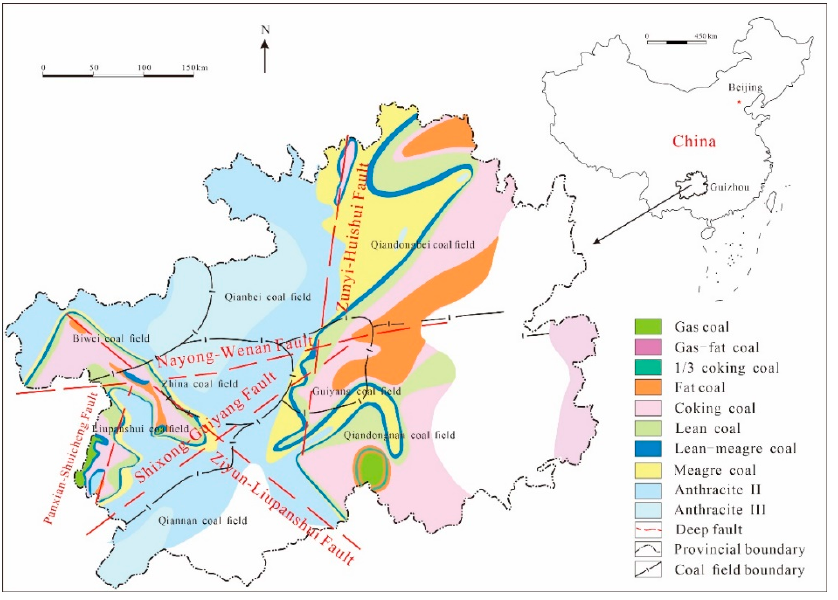
Figure 4. Relationship between deep faults and coal rank in Guizhou. Adapted from [27].